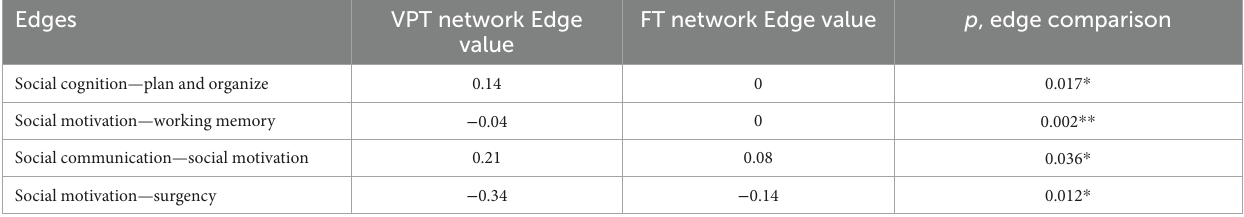
TABLE 3 Comparison between the very preterm (VPT) and full-term (FT) networks in edge values between SRS-2 subscale scores and all other nodes.